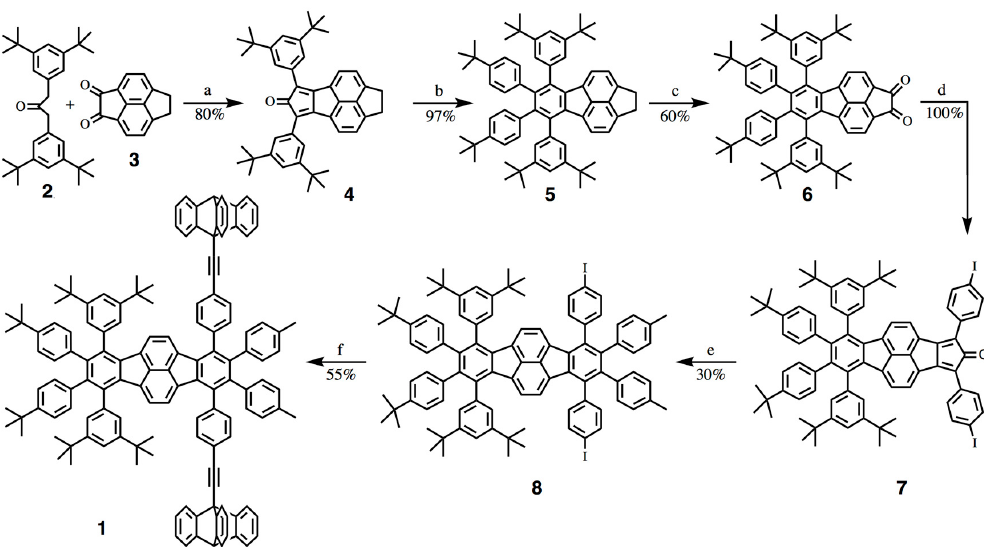
Figure 1. Macroscopic wheelbarrow ( left ), chemical structure of the molecular analogue 1 ( center ), and space-filling model showing its minimum energy conformation ( right ).